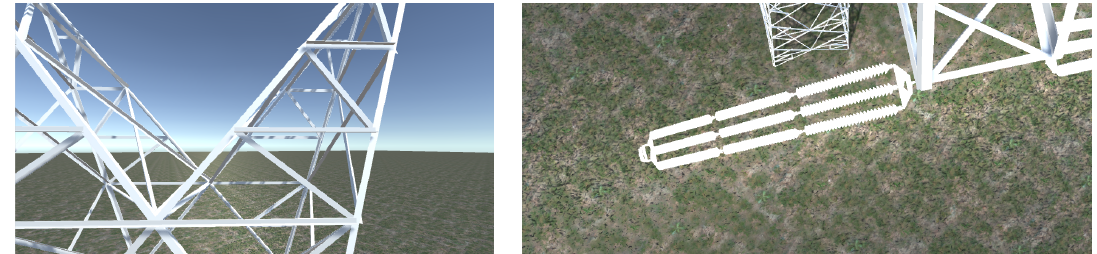
Figure 12. Simulated flight video results (( left ): lateral, ( right ):